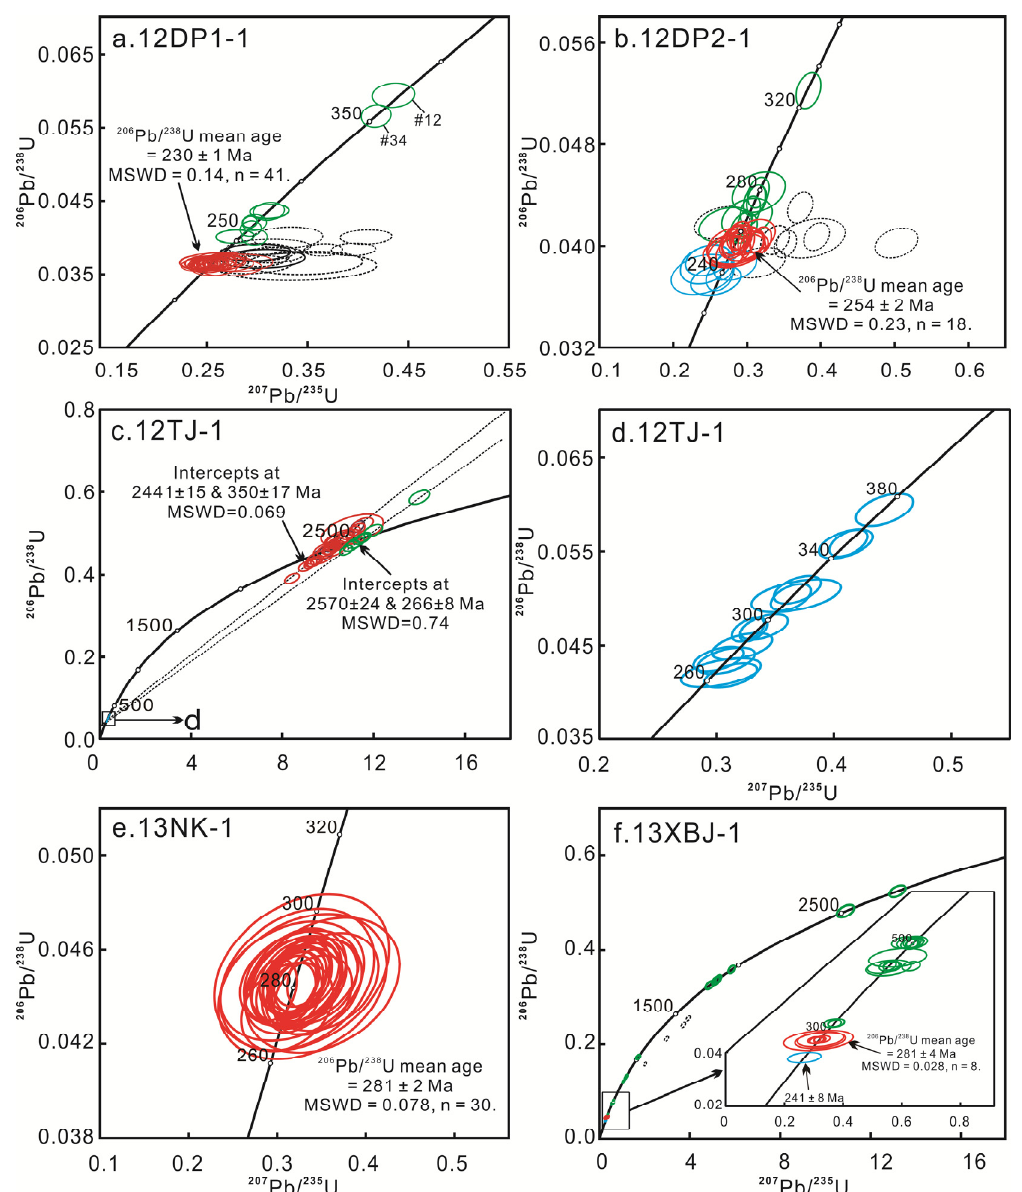
Figure 7. LA ‐ ICP ‐ MS U ‐ Pb concordia diagrams of zircons from the ( a,b ) gneisses, ( c,d ) actinolite Figure 7. LA-ICP-MS U-Pb concordia diagrams of zircons from the ( a , b ) gneisses, ( c , d ) actinolite schist, ( e ) leptynite and ( f ) hornblende ‐ biotite schist in this study.